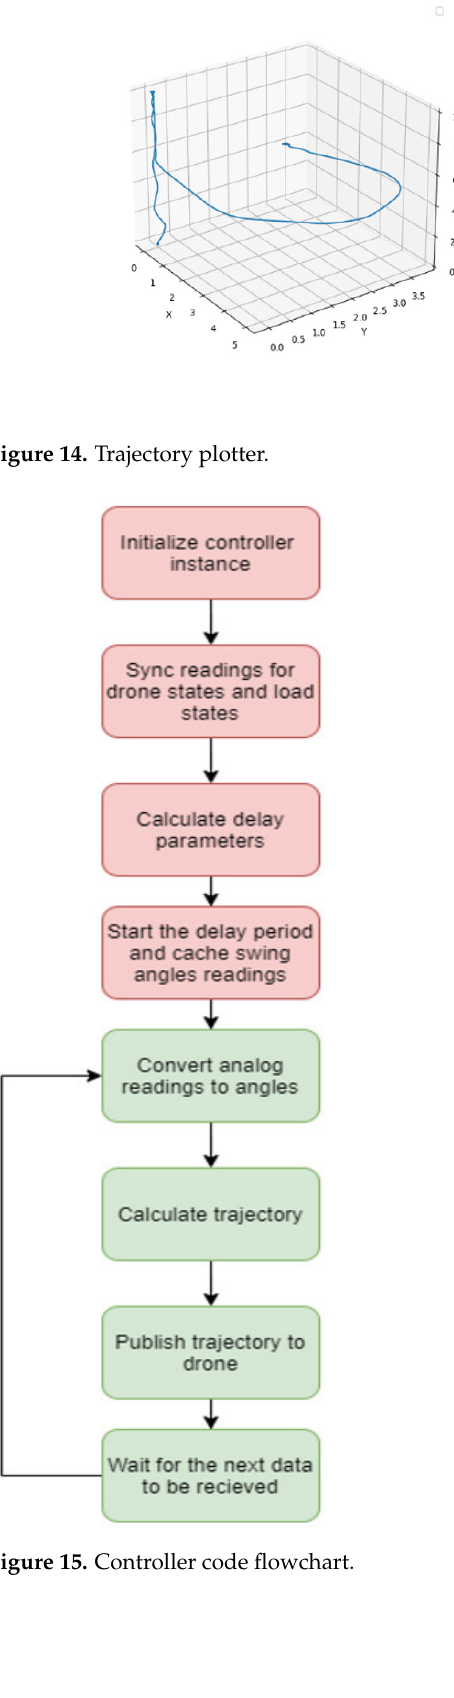
Table 1. Parameters of the quadcopter and the suspended load. Symbol